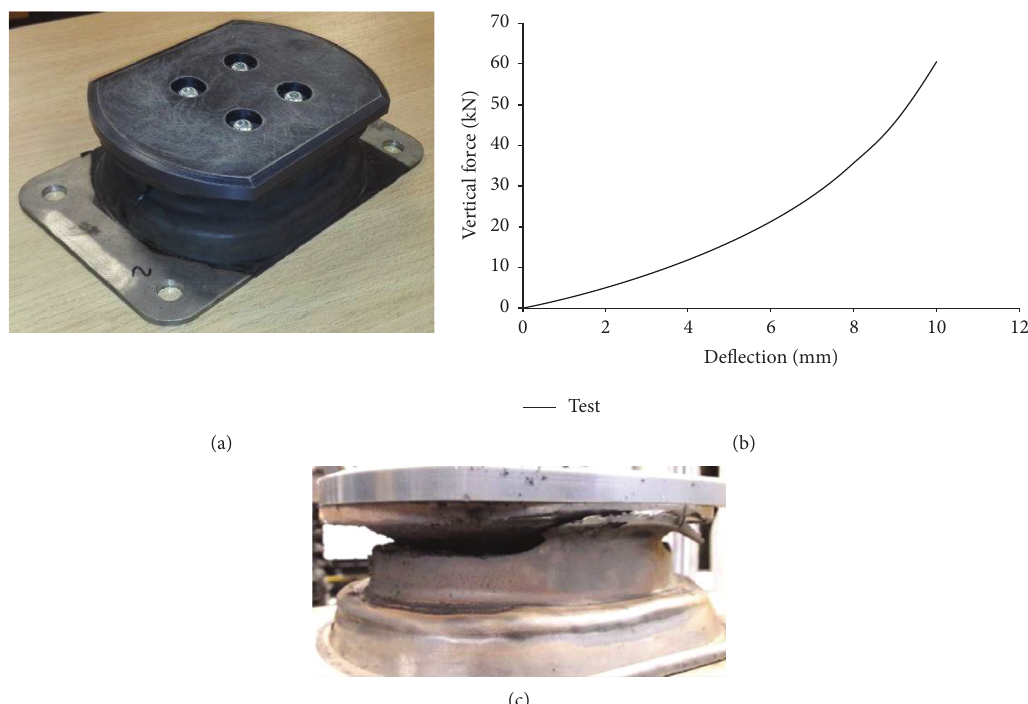
Figure 1: The rail vehicle buffer and its experimental results. (a) The photo of the rail vehicle buffer. (b) The load-deflection curve of the buffer in compression (along the vertical direction) from the test. (c) The failed buffer at circa 200k